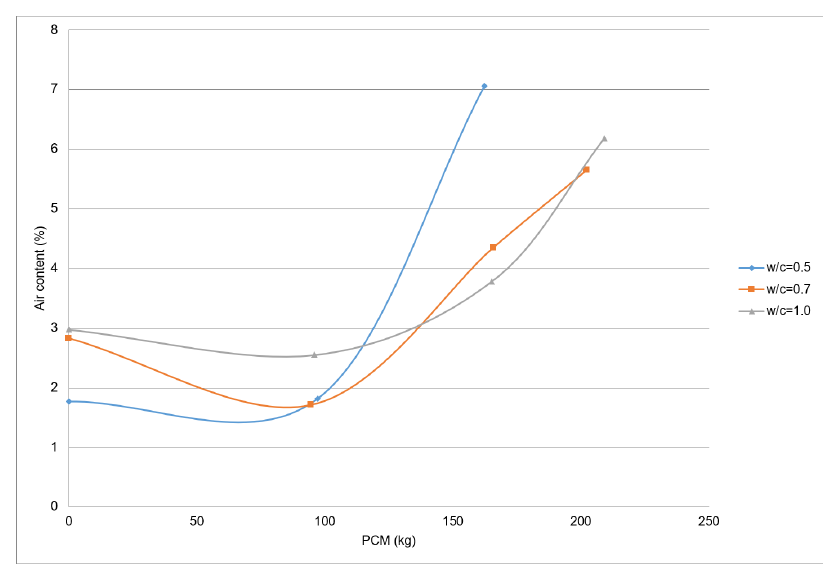
Figure 10. Air content in PX27 and CEM I 52.5 R